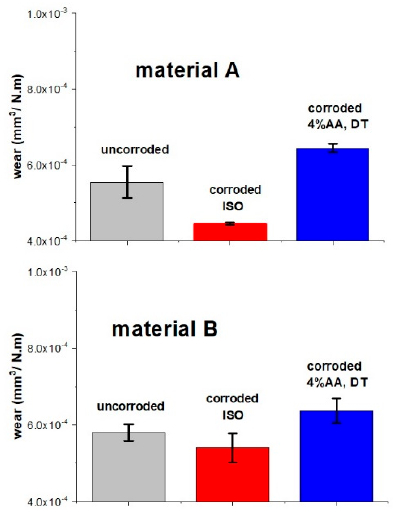
Figure 4. Wear rates of LS 2 -GCs in a uncorroded sample, after static corrosion for 16 h at 80 °C (ISO), and a dynamic test for 96 h (4% AA, DT) in 4% acetic acid for material A and material B.